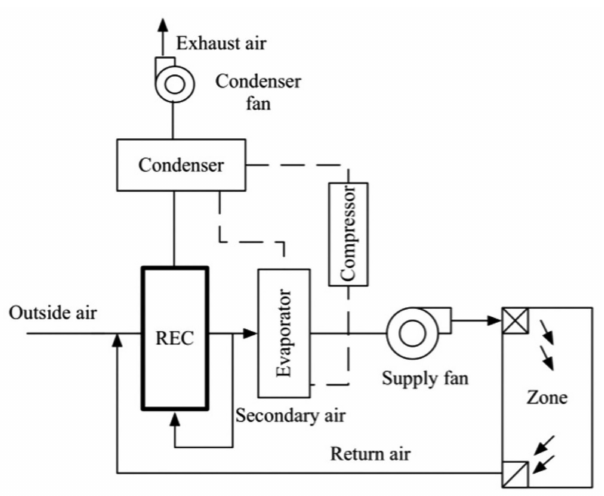
Figure 11. Schematic of RIEC-MVC system. Reprinted with permission from Ref. [59]. Copyright 2019,